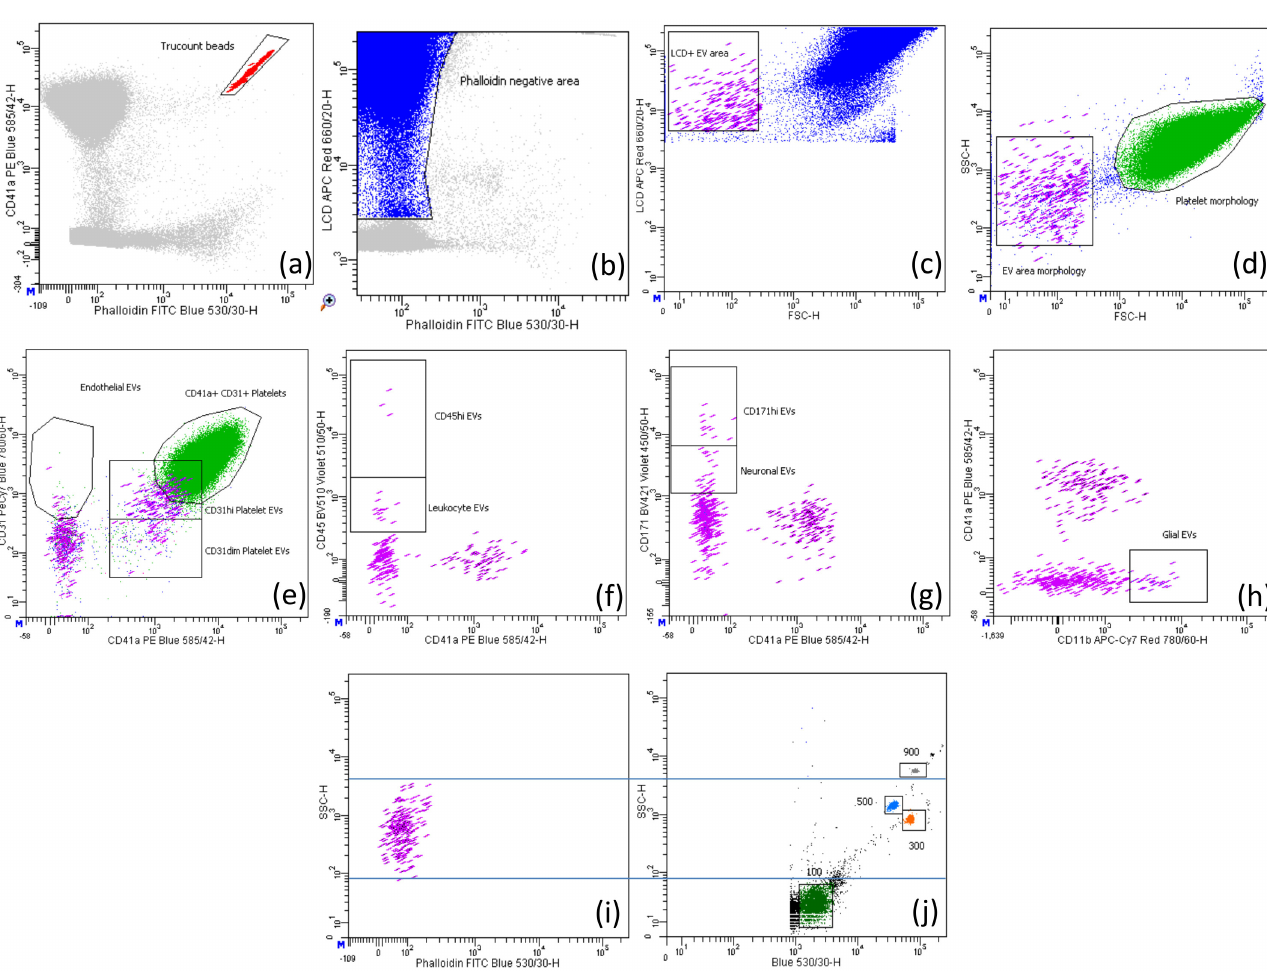
Figure 1. Gating strategy to identify EVs and platelets. ( a ) Counting beads (red) were identified based on their high fluorescence for FITC and PE fluorochromes; ( b ) the phalloidin negative area (blue) contained both extracellular vesicles and platelets. The EV area (violet) was identified by intersecting the lipophilic cationic dye (LCD) positive EV area in ( c ) with the EV area morphologically assessed in ( d ). Platelets (green) were identified by intersecting platelets morphologically detected in ( d ) with those identified by CD31 and CD41a positivity in ( e ). ( e ) EVs double positive for CD31 and CD41a were considered of platelet origin and further divided into CD31dim and CD31hi; EVs positive for CD31 but negative for CD41a were considered of endothelial origin. EVs positive for CD45, CD171 and CD11b were considered leukocyte ( f ), neuronal ( g ), and glial ( h ) origins, respectively. In ( f , g ), we also gated CD45hi and CD171hi events, respectively, that could be either EVs expressing high levels of these specific markers or crystals. The comparison between the size of EVs ( i ) and of the Megamix beads ( j ) is shown.